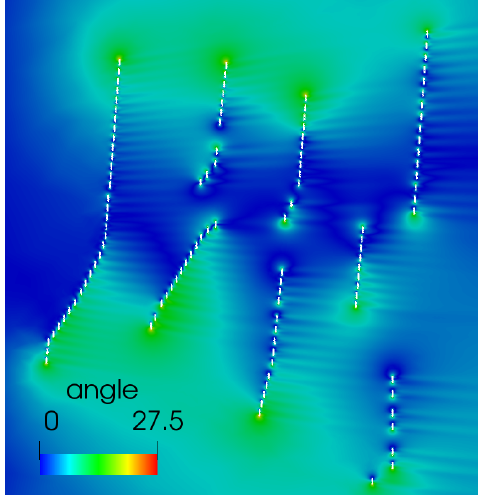
Figure 19. Angle between the inflow direction and the computed flow direction at the Sisante wind farm (115